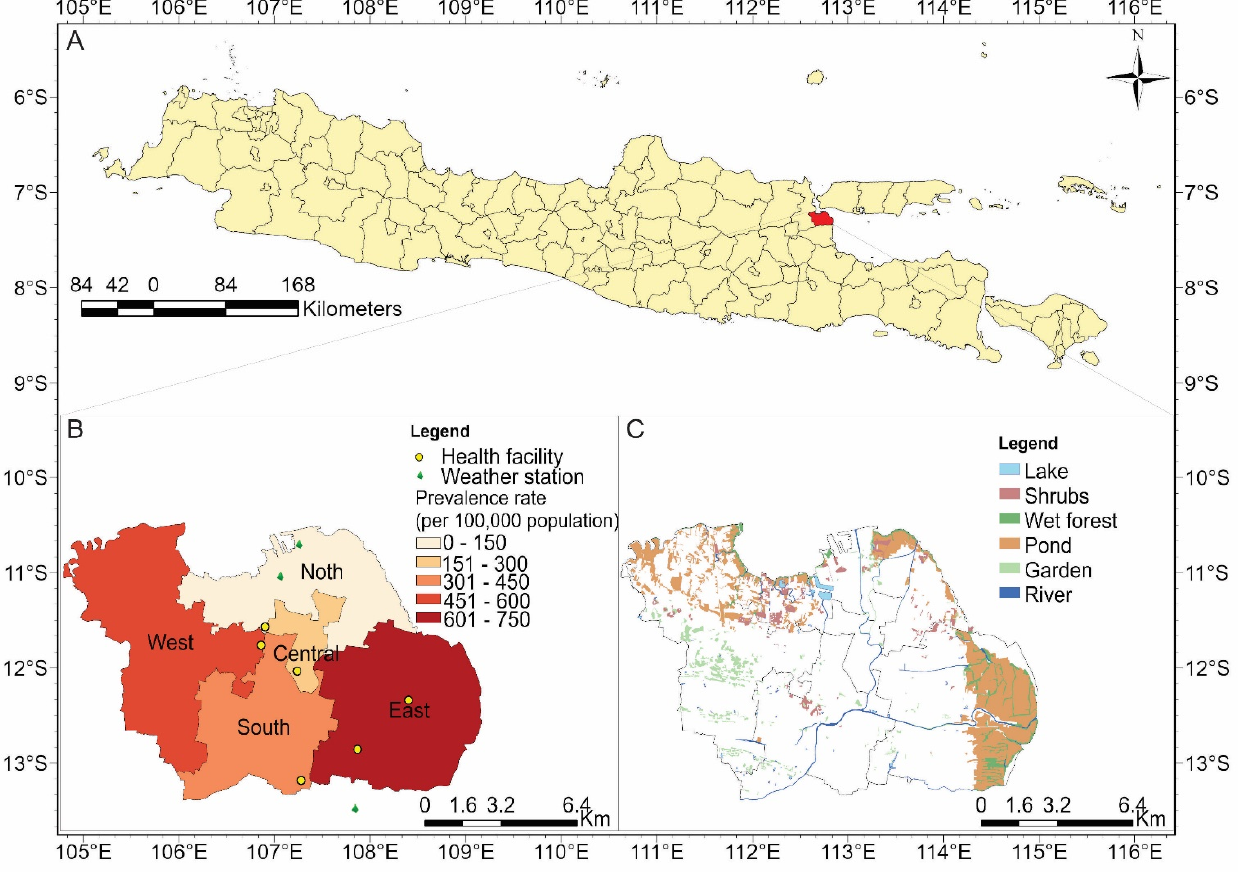
Figure 1. ( A ) Location of Surabaya on island of Java in Indonesia; ( B ) locations of weather stations and health facilities, and prevalence rate of diarrhea cases per 100,000 populations, from January 2018 to September 2020; ( C ) land use map for Surabaya.